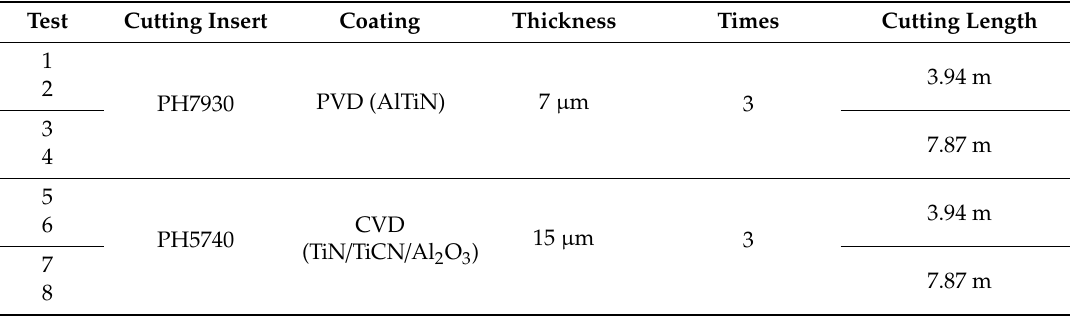
Table 6. Cutting insert reference, coating and cutting length for each